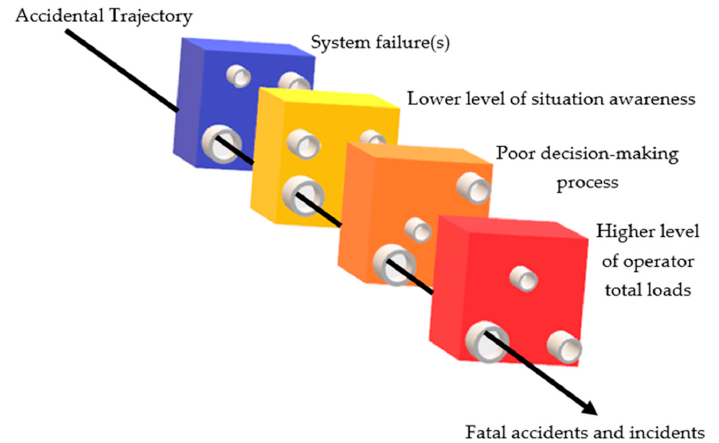
Figure 3. The Swiss Cheese Model (SCM) of operator error causation.